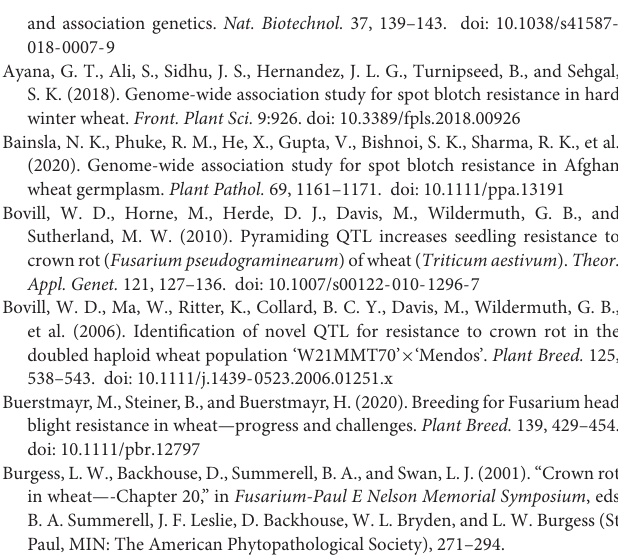
Supplementary Figure 1 | Combined chromosome distribution map for all the QTLs conferring resistance to common root rot (spot blotch), Fusarium crown rot, and sharp eyespot in wheat. Supplementary Table 1 | Chromosome location data for all the reported